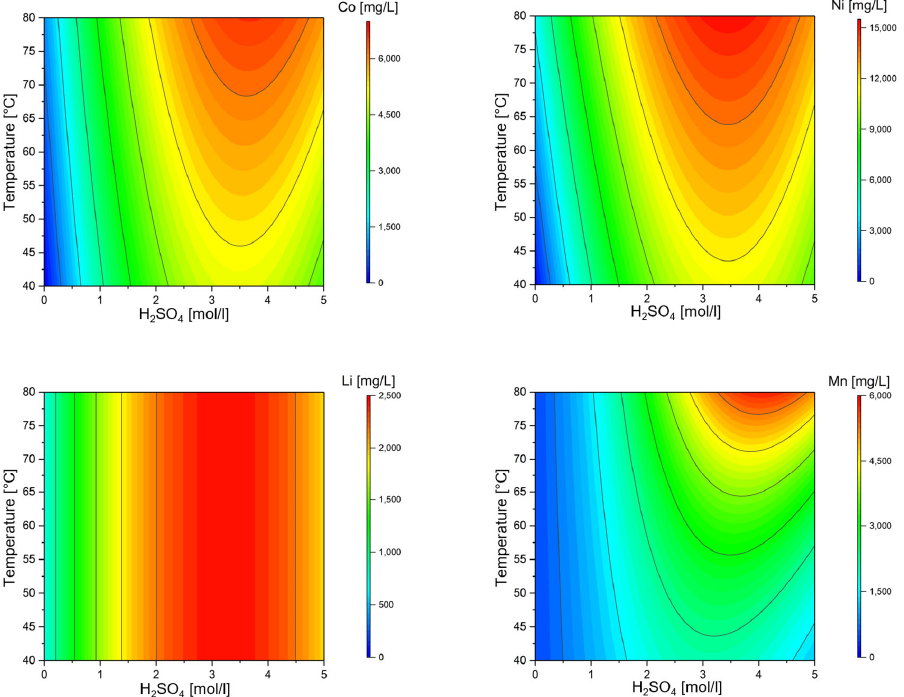
Figure 11. Contour plot of the statistical test evaluation for the leached fractions of Co, Ni, Li and Mn without the addition of Si met , SiO 2 or H 2 O 2 as a function of temperature and H 2 SO 4 concentration. Another influencing factor for optimal leaching results is the process time. To study this parameter in detail, samples were taken for all experiments after a period of 30, 60, 90, 120 and 240 min and analysed for valuable metal contents. Figure 12 shows an example of the comparison of the concentration curves for results at (a) 0% silicon content (Si met + SiO 2 ) and (b) 20% silicon content in the sum of Si met and SiO 2 . It can be seen that the valuable metals dissolve quickly in both cases. From this, the conclusion can be drawn that the leaching time after 90 min as a minimum only plays a subordinate role and thus does not represent the main influencing factor for the leaching efficiency in this system.